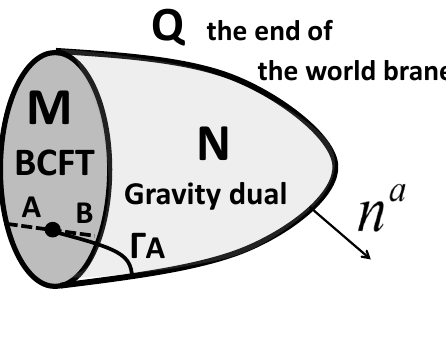
Figure 1 . A sketch of AdS/BCFT. We have in mind a d = 2 example. A BCFT is defined on the manifold M and its gravity dual is given by the region N . The boundary of M is extended into the bulk as the surface Q , called the end of the world brane. The dotted line represents a time slice on the boundary M , which is divided into two subregions A and B . The entanglement entropy S A in the BCFT can be holographically computed as the geodesic length of Γ A which starts from the boundary ∂A and ends on a point on the surface Q , where we minimize the geodesic length by changing the location of the point on Q